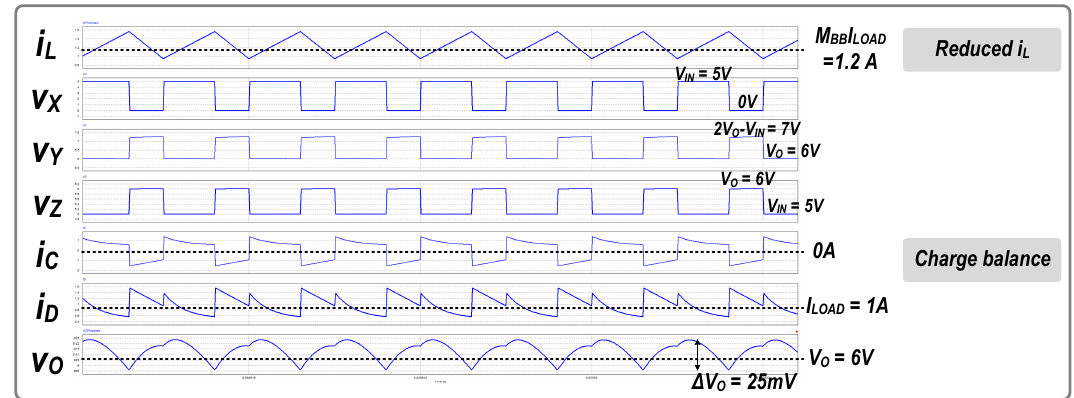
Figure 15. Simulation waveforms of buck-boost converter with ETM.